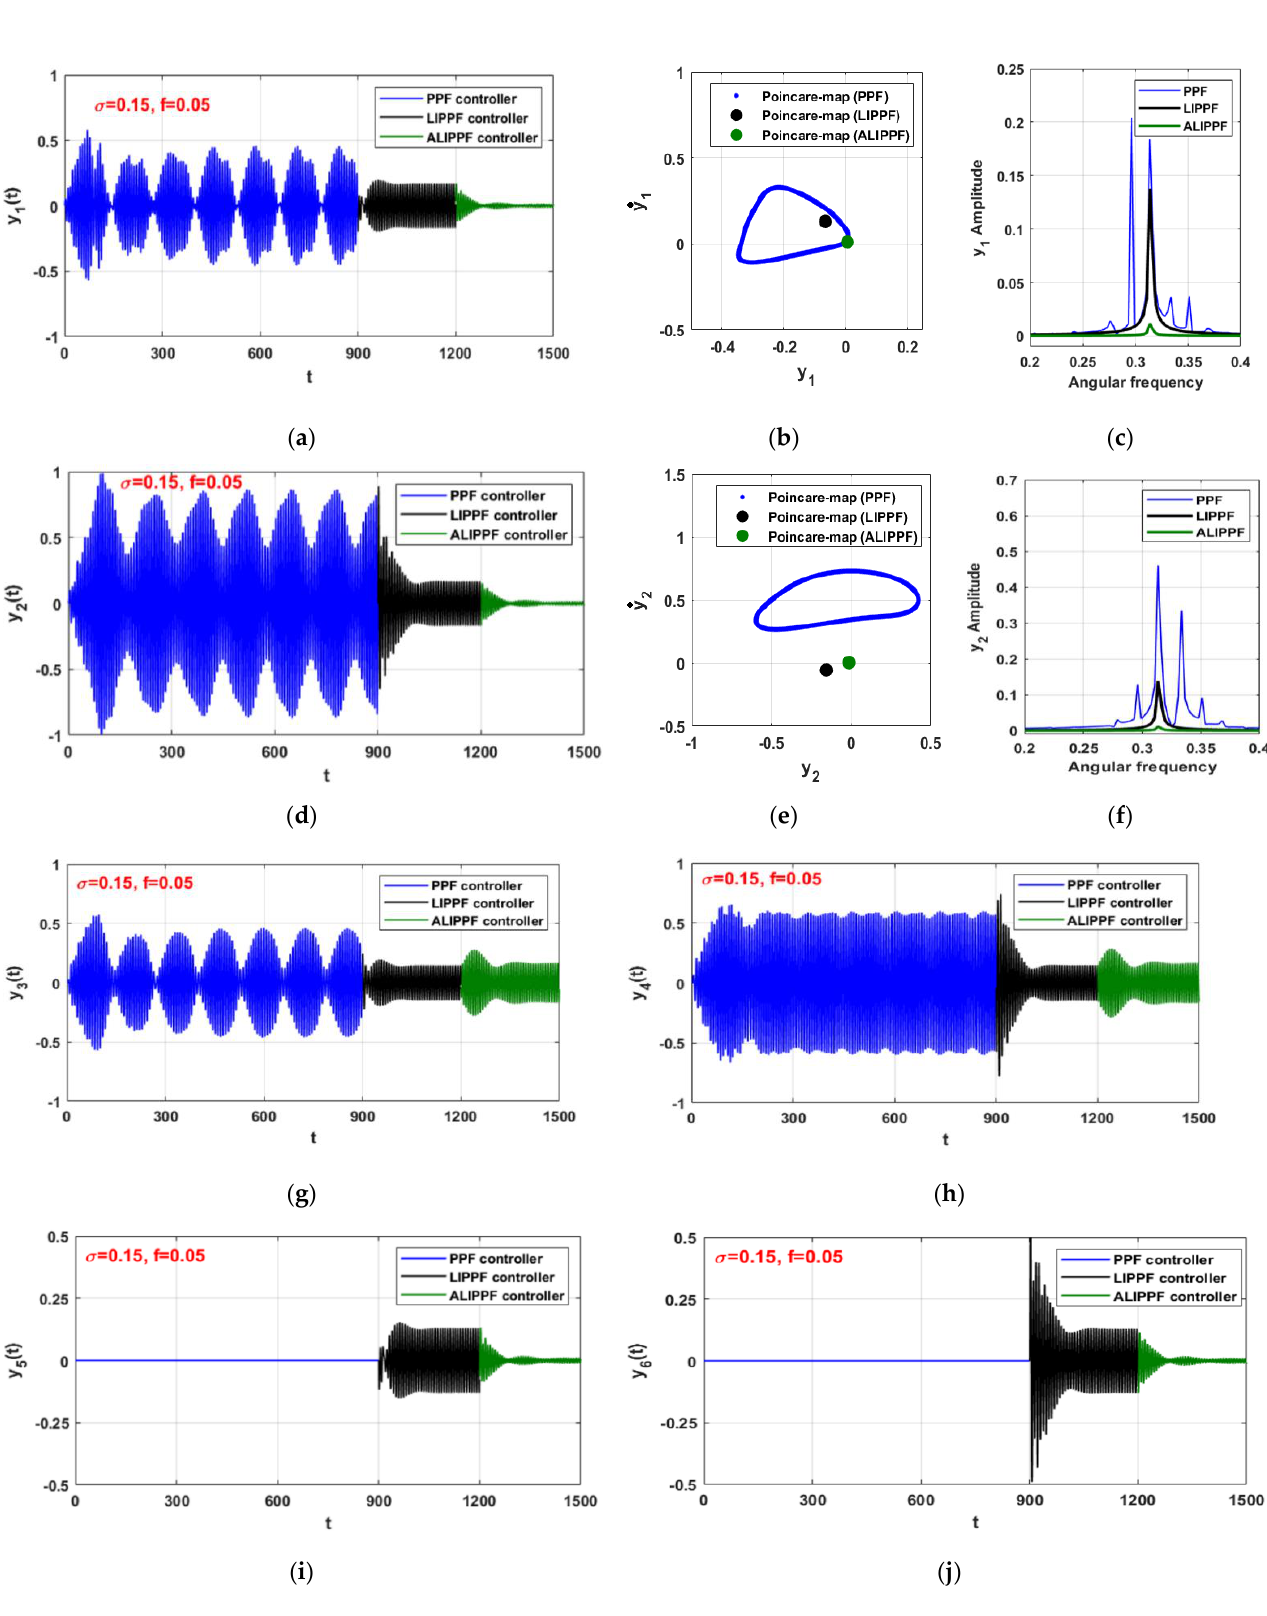
Figure 14. Rotor electro-magnetic suspension time response, Poincare map, and the frequency spectrum with the PPF-controller, LIPPF-controller, and ALIPPF-controller at σ = 0.15 and f = 0.05: ( a , d ) the temporal oscillations of the rotor system in X 1 and X 2 directions, ( b , e ) the corresponding Poincare map of the rotor system, ( c , f ) the corresponding frequency spectrum of the rotor, and ( g – j ) the temporal oscillations of the controllers.